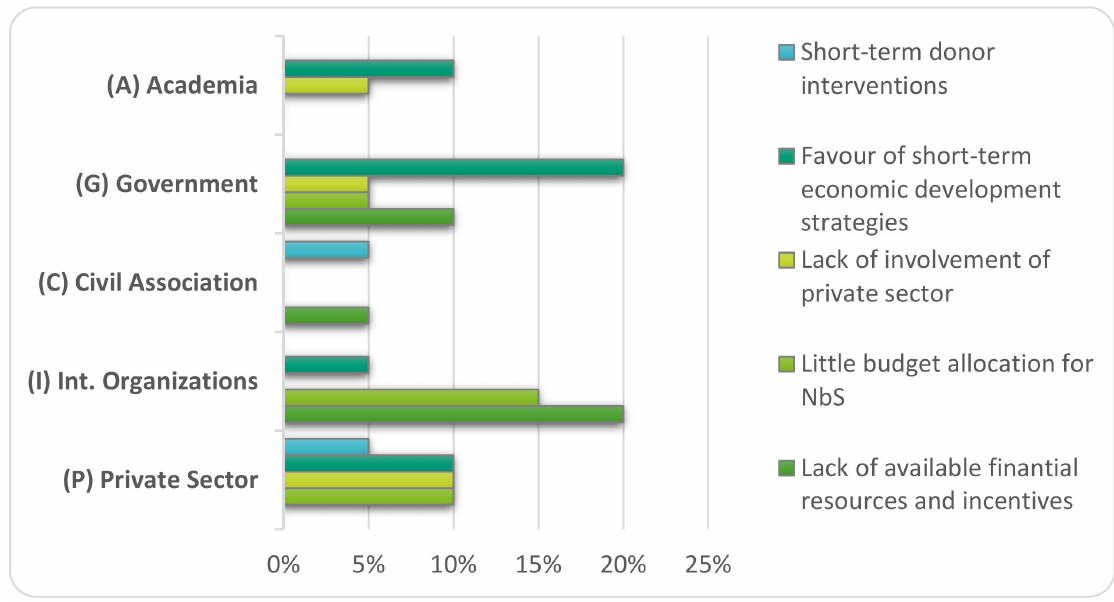
Figure 5. Financial barriers perceived per group of stakeholders. Source: